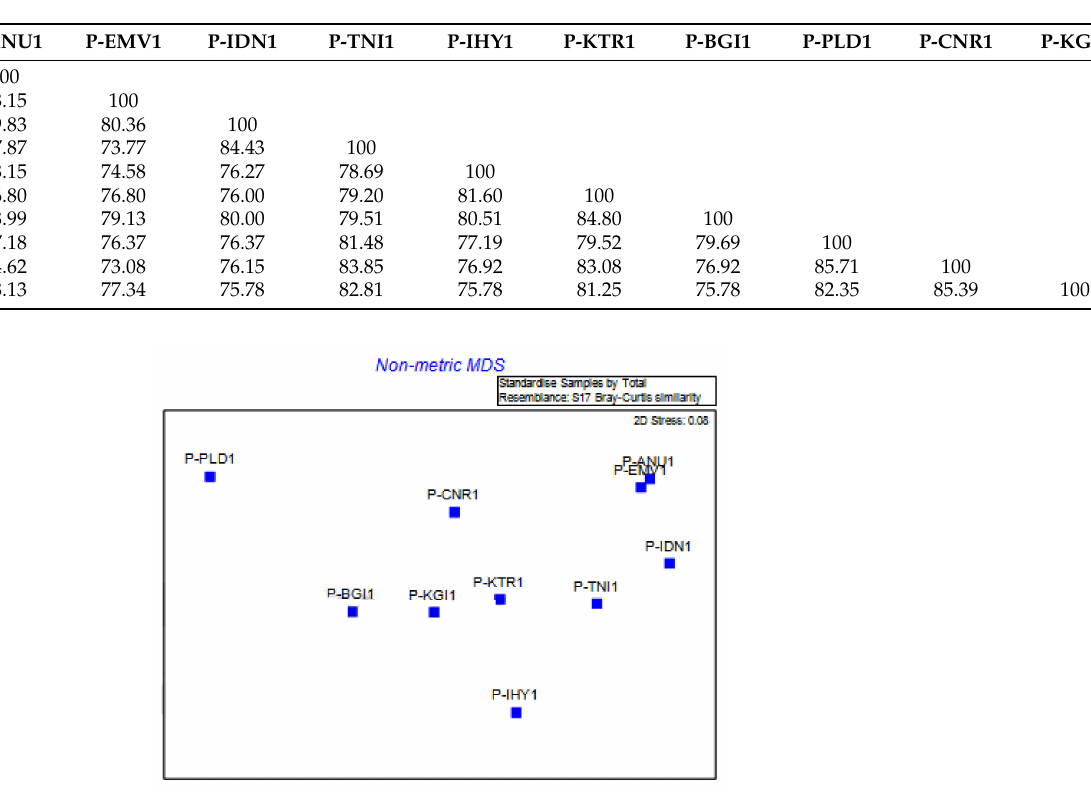
Table 3. Similarity matrix of the isolates of E. pisi generated by RAPD analysis.